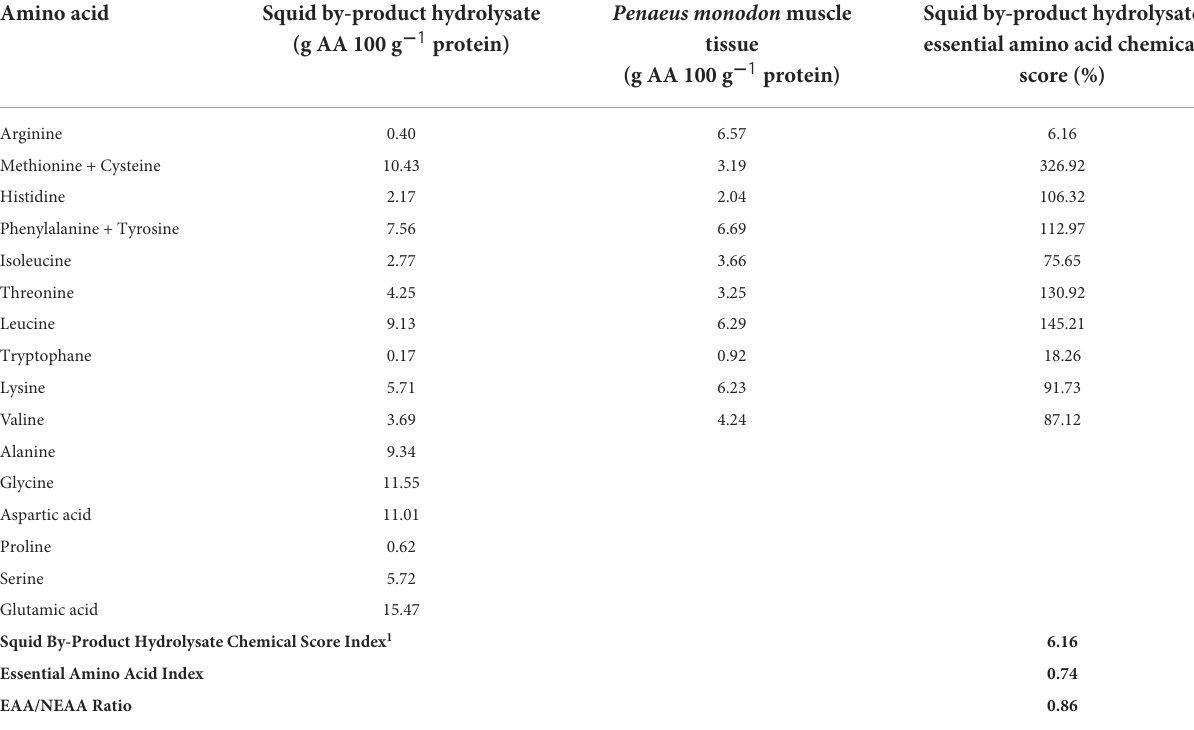
TABLE 4 Amino acid content, chemical score, chemical score index, EAAI, EAA/NEAA ratio of the squid by-product hydrolysate. Amino